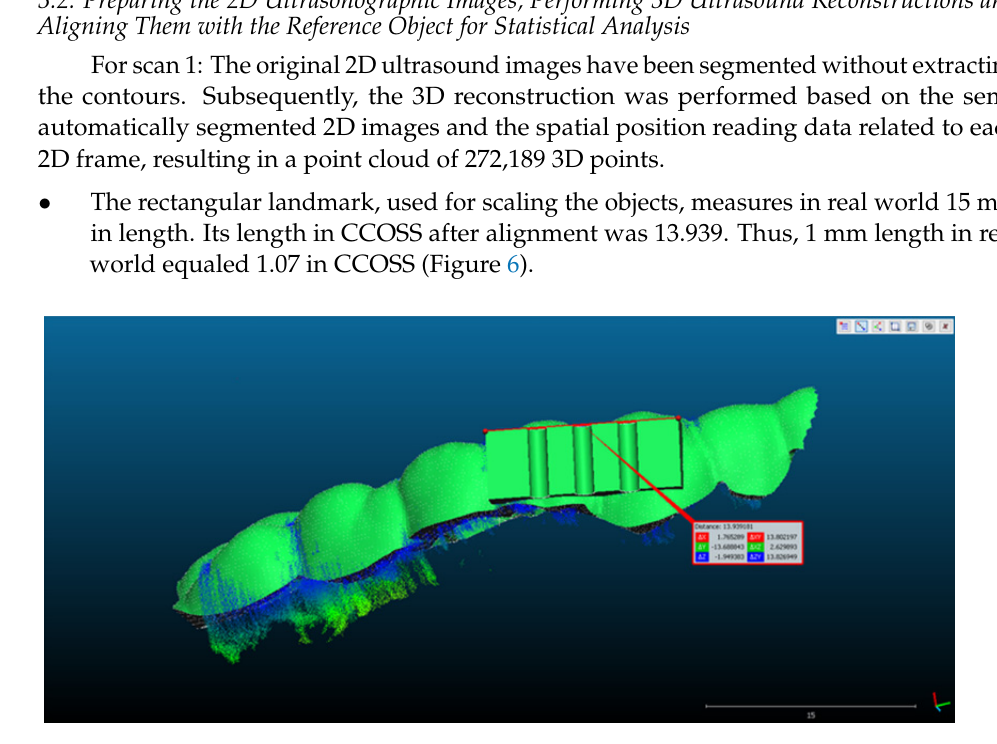
Figure 5. The scaling of the optical scan of the mouth guard, after it had been aligned with the ref- erence object.